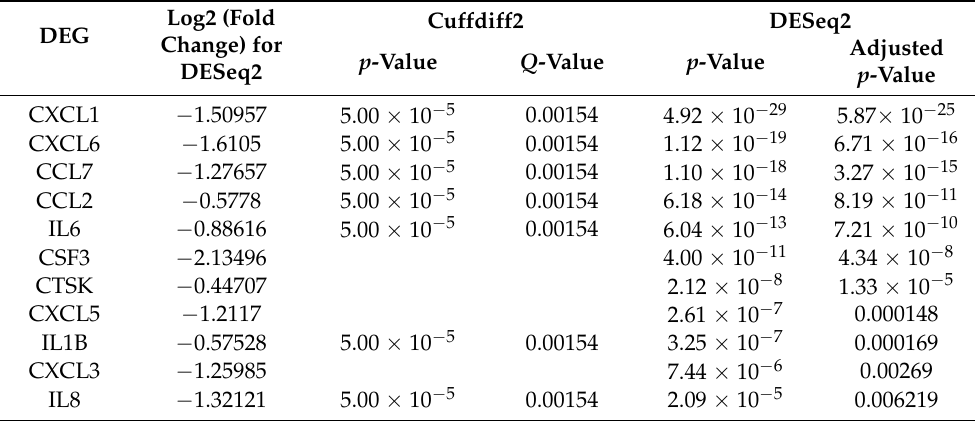
Table 1. SASP genes identified as differentially expressed genes (DEGs) by DSEq2. The SASP genes with a blue shade were also identified using the Cuffdiff2 method in our original paper [25]. The p -value was calculated based on fold change using a Wald test. The BH method was used to control the false discovery